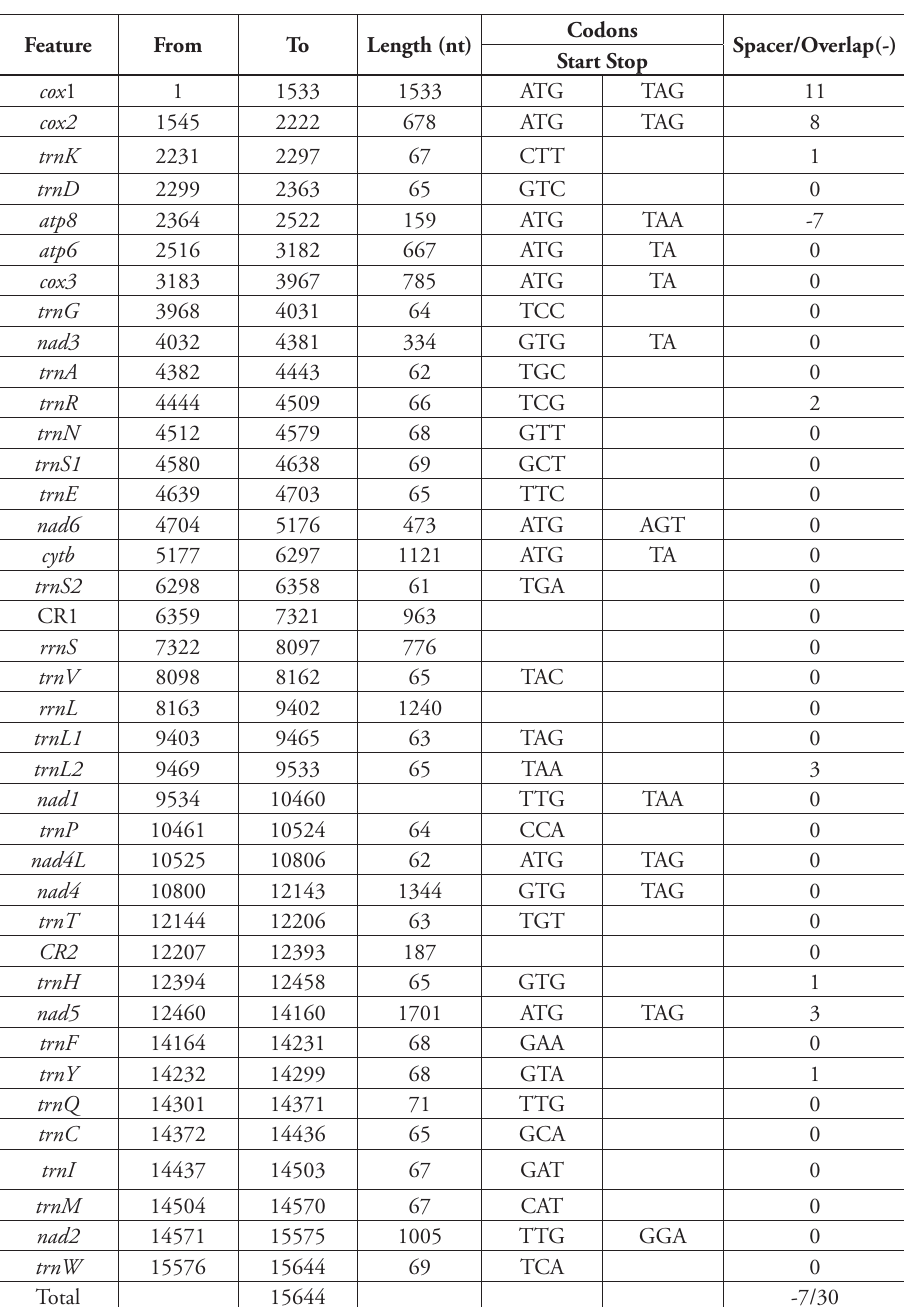
Table 1. Organization of the mitochondrial genome of Asiomorpha coarctata .